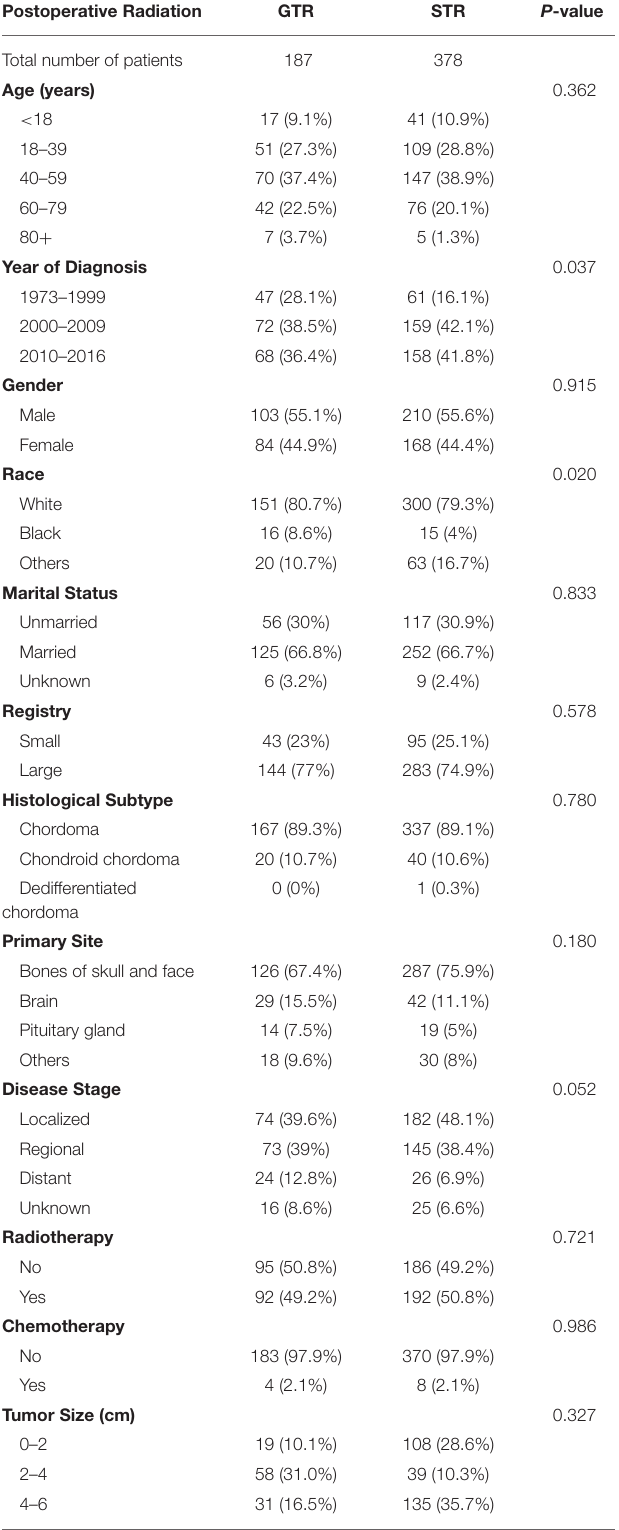
TABLE 3 | Comparison of patients with skull base chordomas receiving GTR or STR. Postoperative Radiation